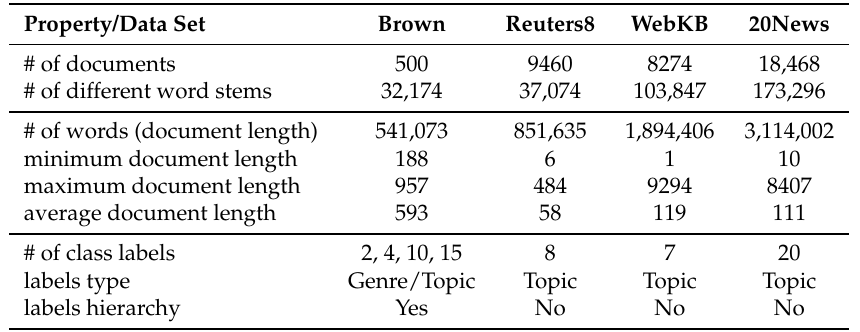
Table 1. Properties of the four document classification benchmarks measured on preprocessed documents, that is after the tokenization, removal of stop words and stemming. Document length (minimum, maximum, and average) is measured in number of word